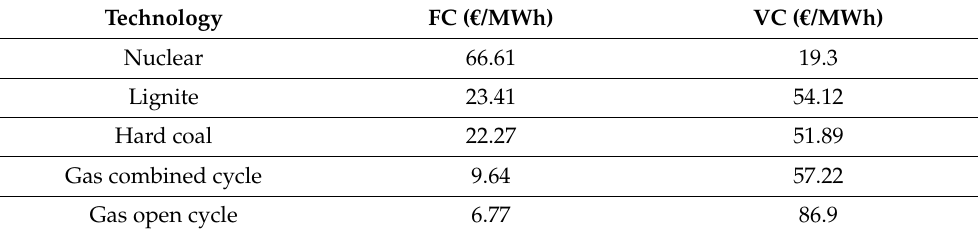
Table A1. Fixed and variable costs of thermal technologies. Data from references [38].